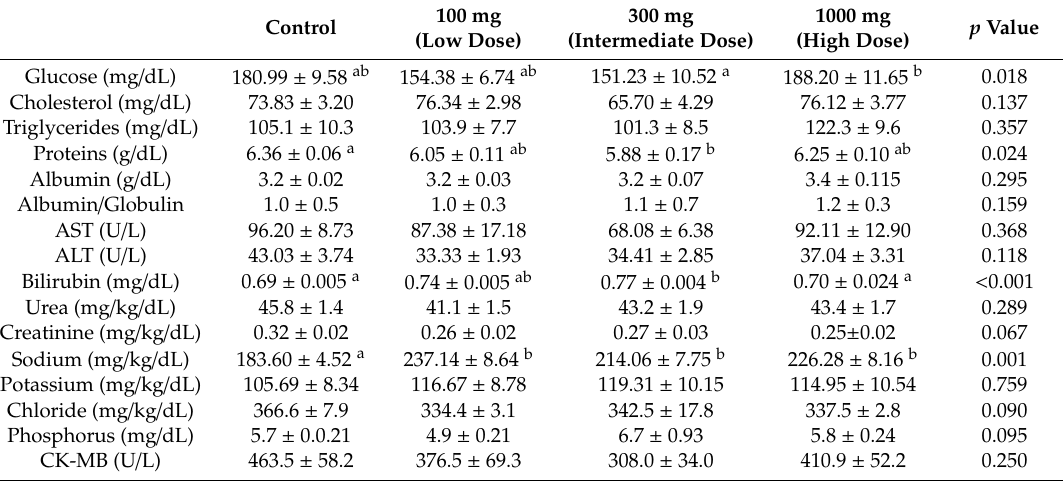
Table 4. Plasma biochemical parameters after 90 days of intervention with di ff erent doses of the VOO extract.